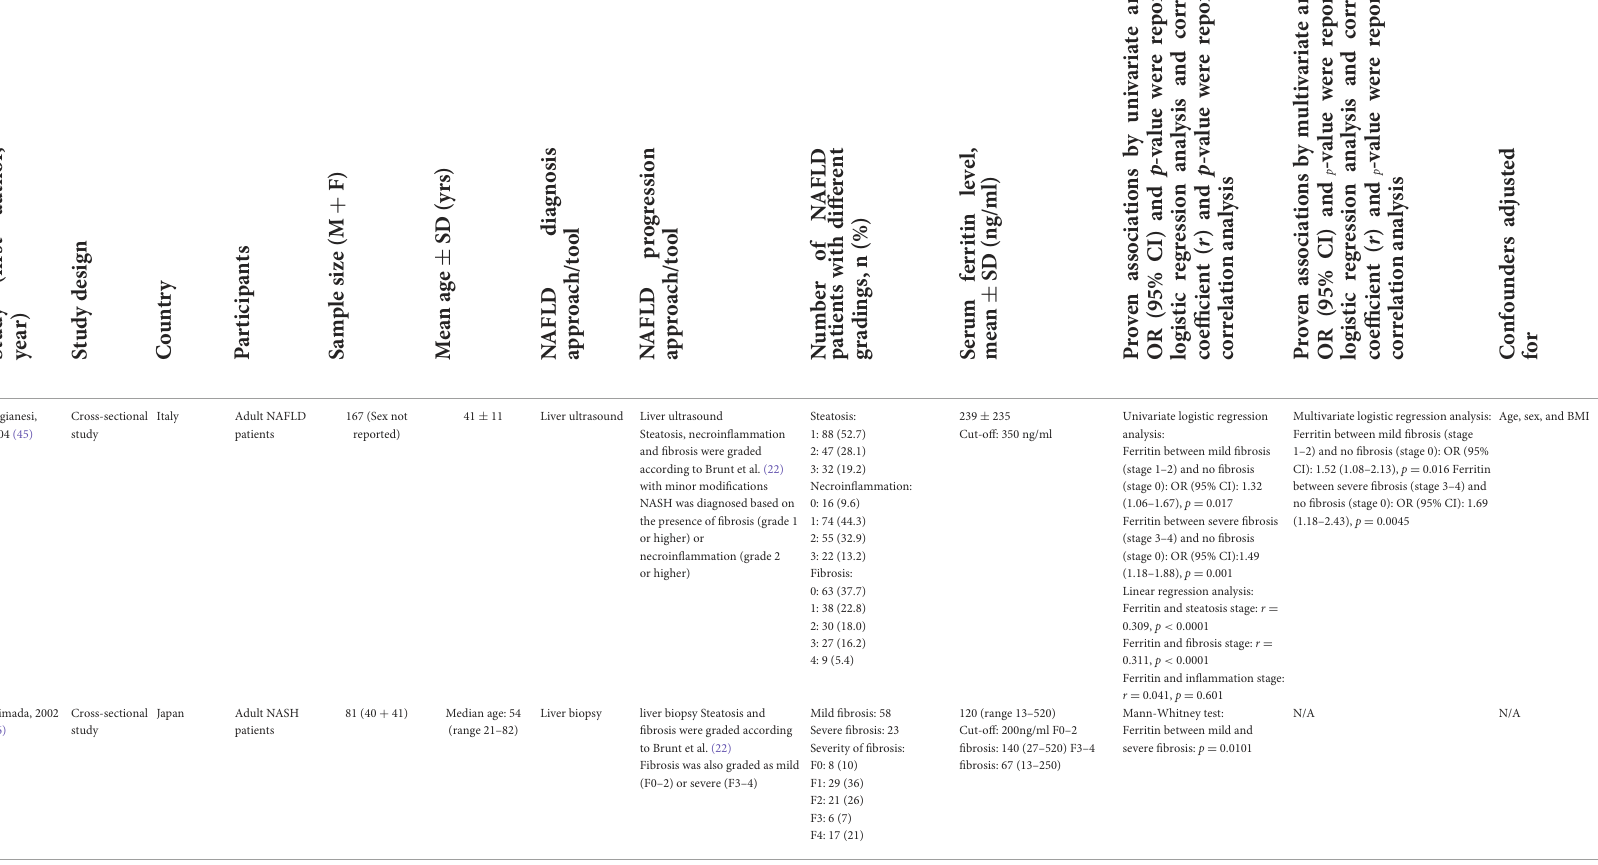
Mann-Whitneytest: Ferritinbetweenmildand severefibrosis: p = 0.0101